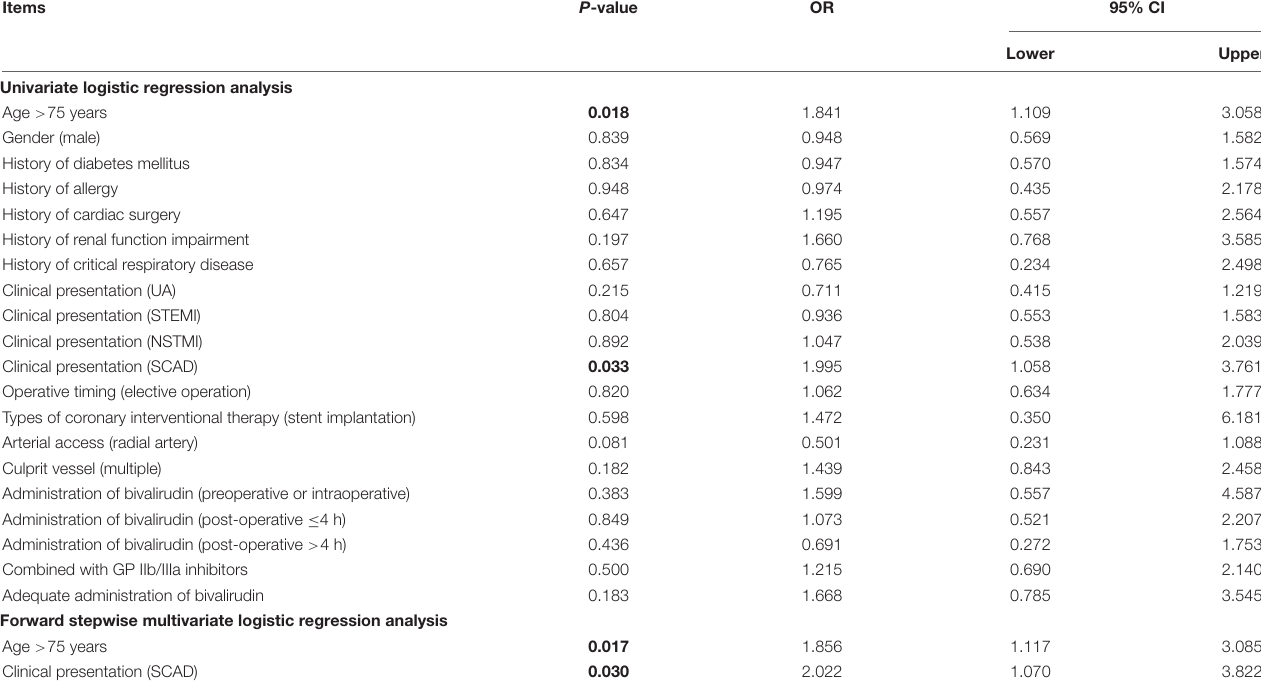
TABLE 3 | Logistic regression analysis for ADRs.